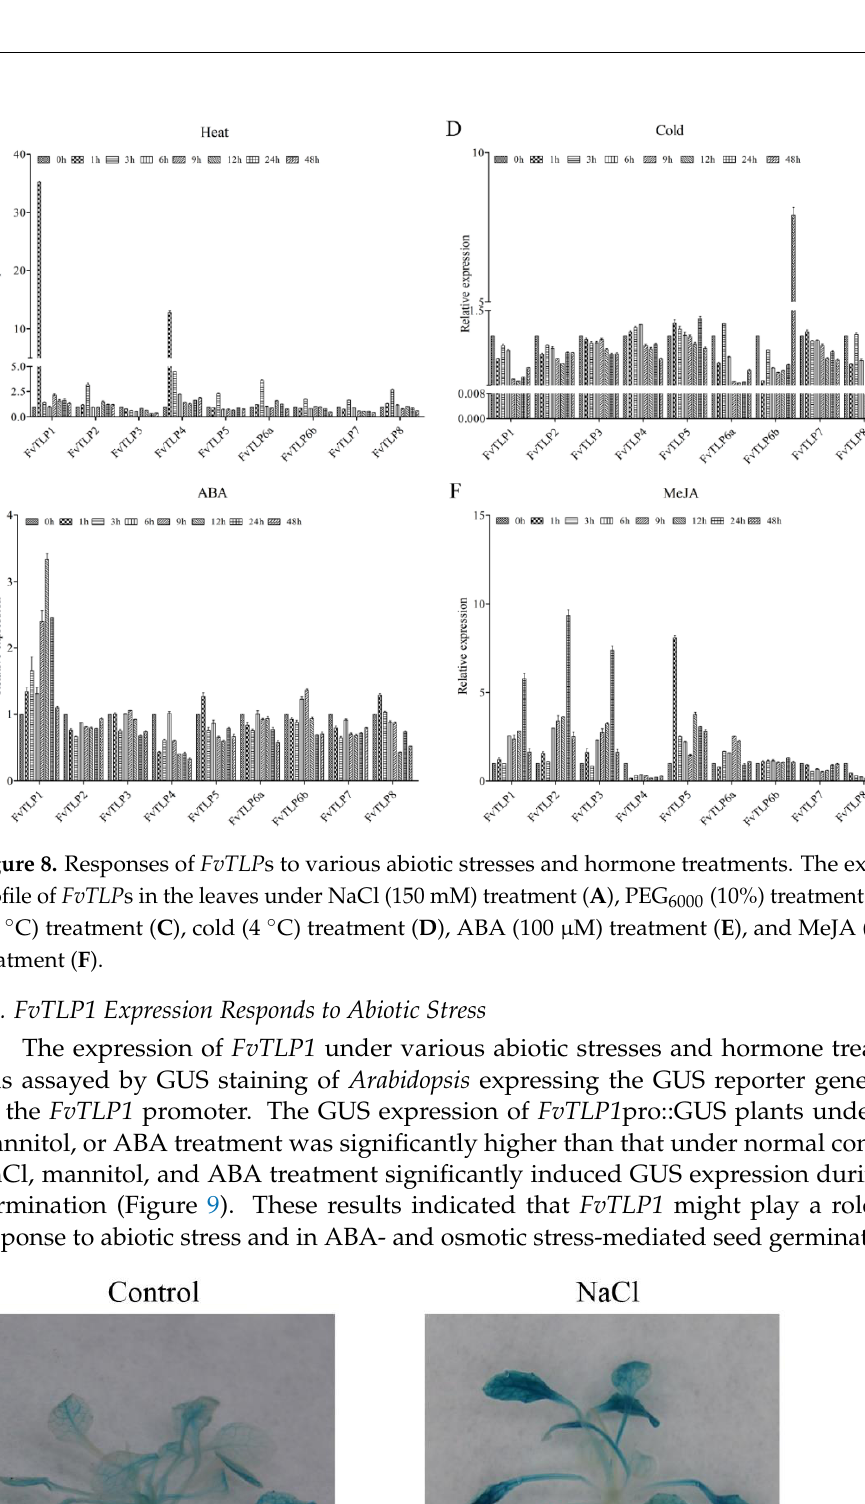
Figure 9. Histochemical GUS staining of FvTLP 1pro::GUS transgenic Arabidopsis . Three-week-old seedlings growing on half-strength MS medium were transferred to half-strength MS medium with- out or with 150 mM NaCl, 200 mM mannitol, or 100 μM ABA. Seeds of FvTLP 1pro::GUS transgenic Arabidopsis were surface-sterilized and germinated on half-strength MS medium supplemented without or with 75 mM NaCl, 75 mM mannitol, or 0.25 μM ABA.